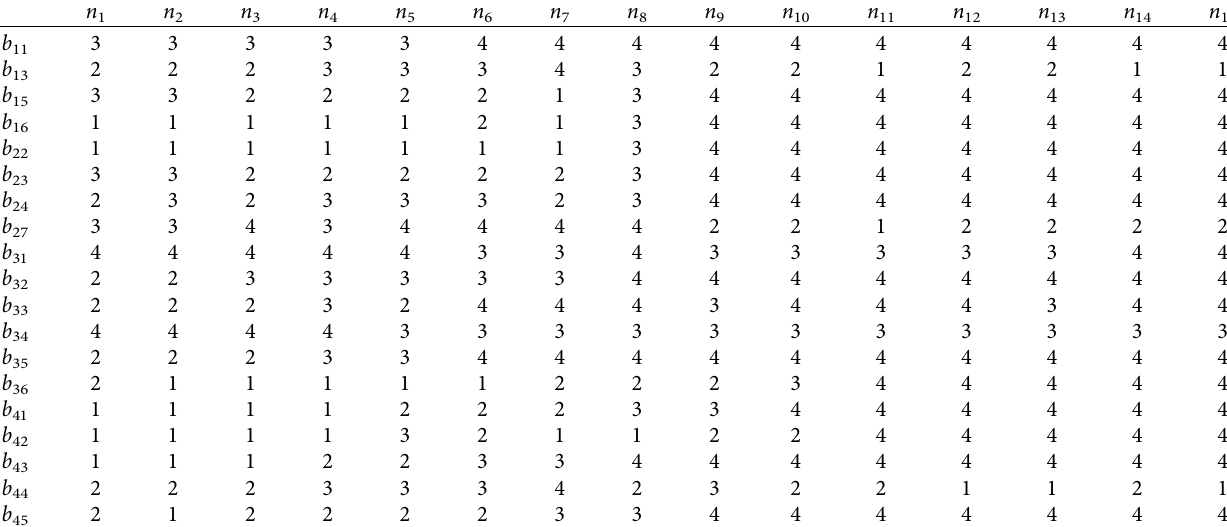
Table 4: Qualitative indicator assignment discrete